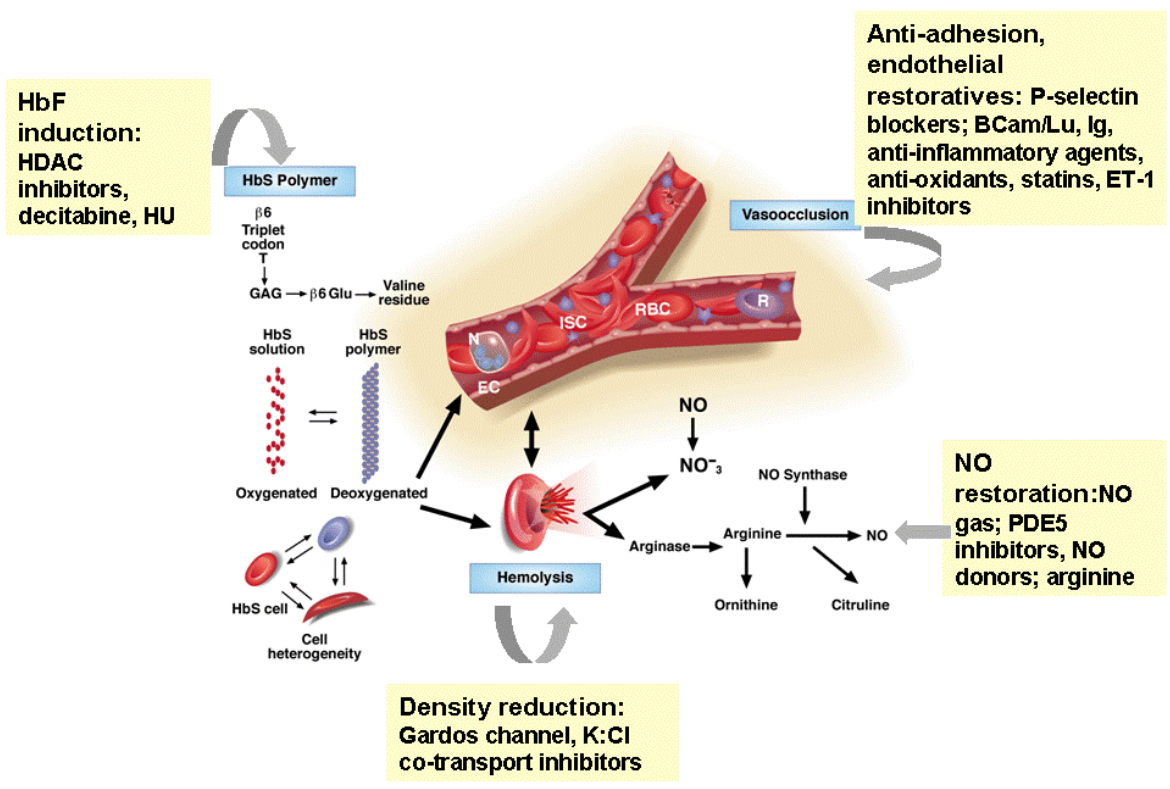
FIGURE 4. The pathophysiology of sickle cell disease and sites where drug treatment could be focused. Treatment by polymerization inhibition by increasing HbF concentration, interrupting intercellular interactions and reducing reperfusion injury, increasing NO bioavailability and reducing sickle erythrocyte density, provide a basis for combination chemotherapeutic